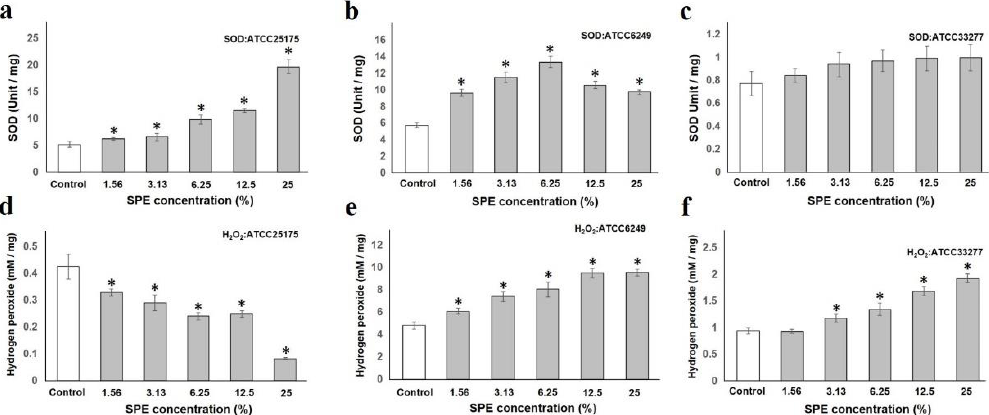
Figure 1. SPE induces oxidative stress. SOD levels in tested bacteria is shown in ( a – c ) (( a ): S. mutans ATCC25175, ( b ): S. oralis ATCC6249, and ( c ): P. gingivalis ATCC33277) compared to test strains with control. Amount of hydrogen peroxide is shown in ( d – f ) (( d ): S. mutans ATCC25175, ( e ): S. oralis ATCC6249, and ( f ): P. gingivalis ATCC33277) compared to test strains with control. Each sample ( n = 6) indicated the statistical significance of differences between control and treated samples, determined using one-way ANOVA with Scheffe’s test (* p < 0.05).